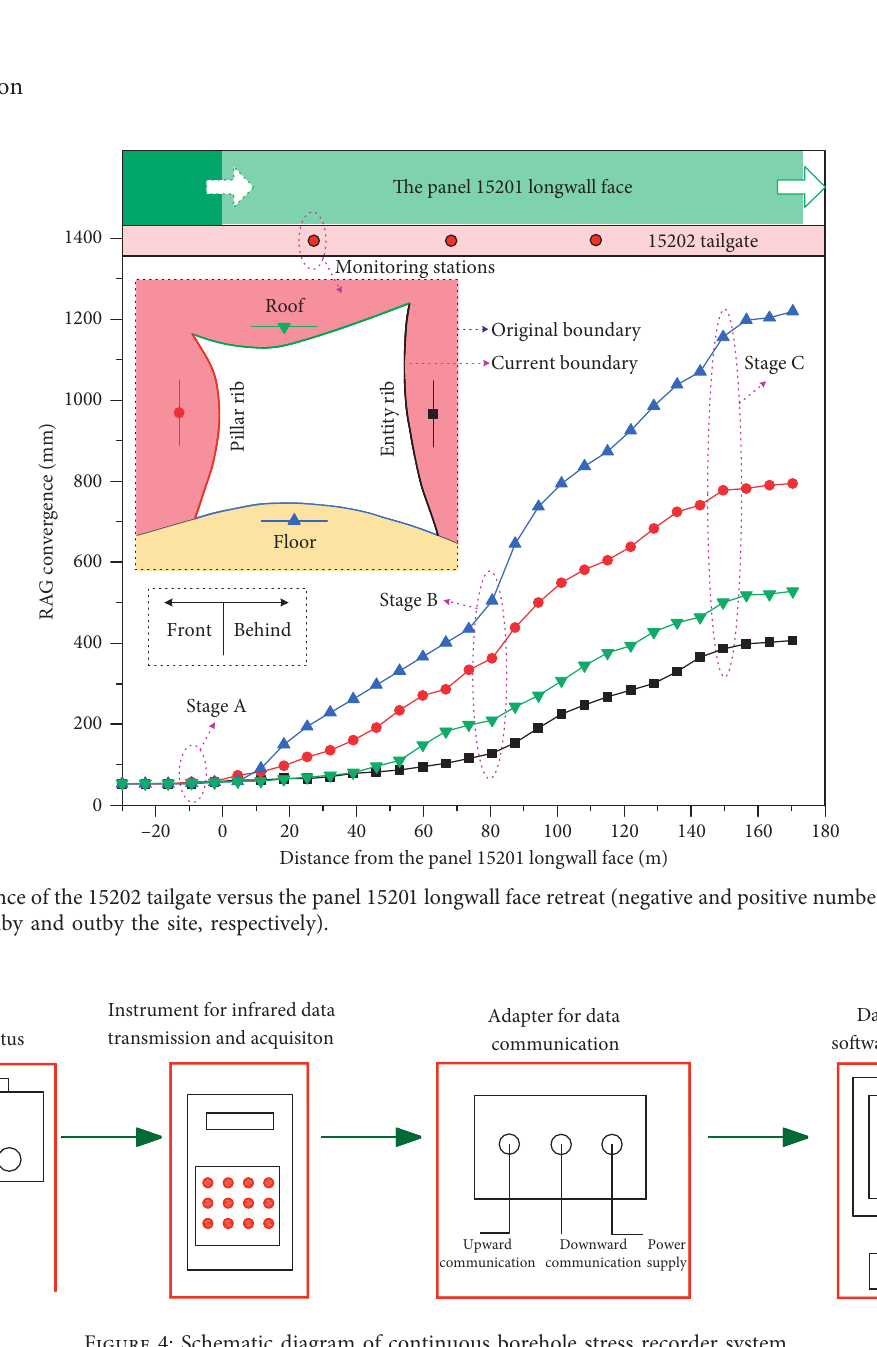
Figure 4: Schematic diagram of continuous borehole stress recorder system.